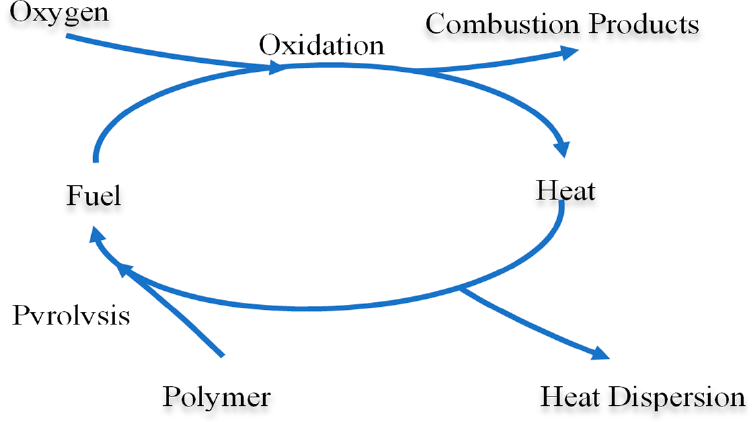
Figure 1. Representation of the fire loop model [2].